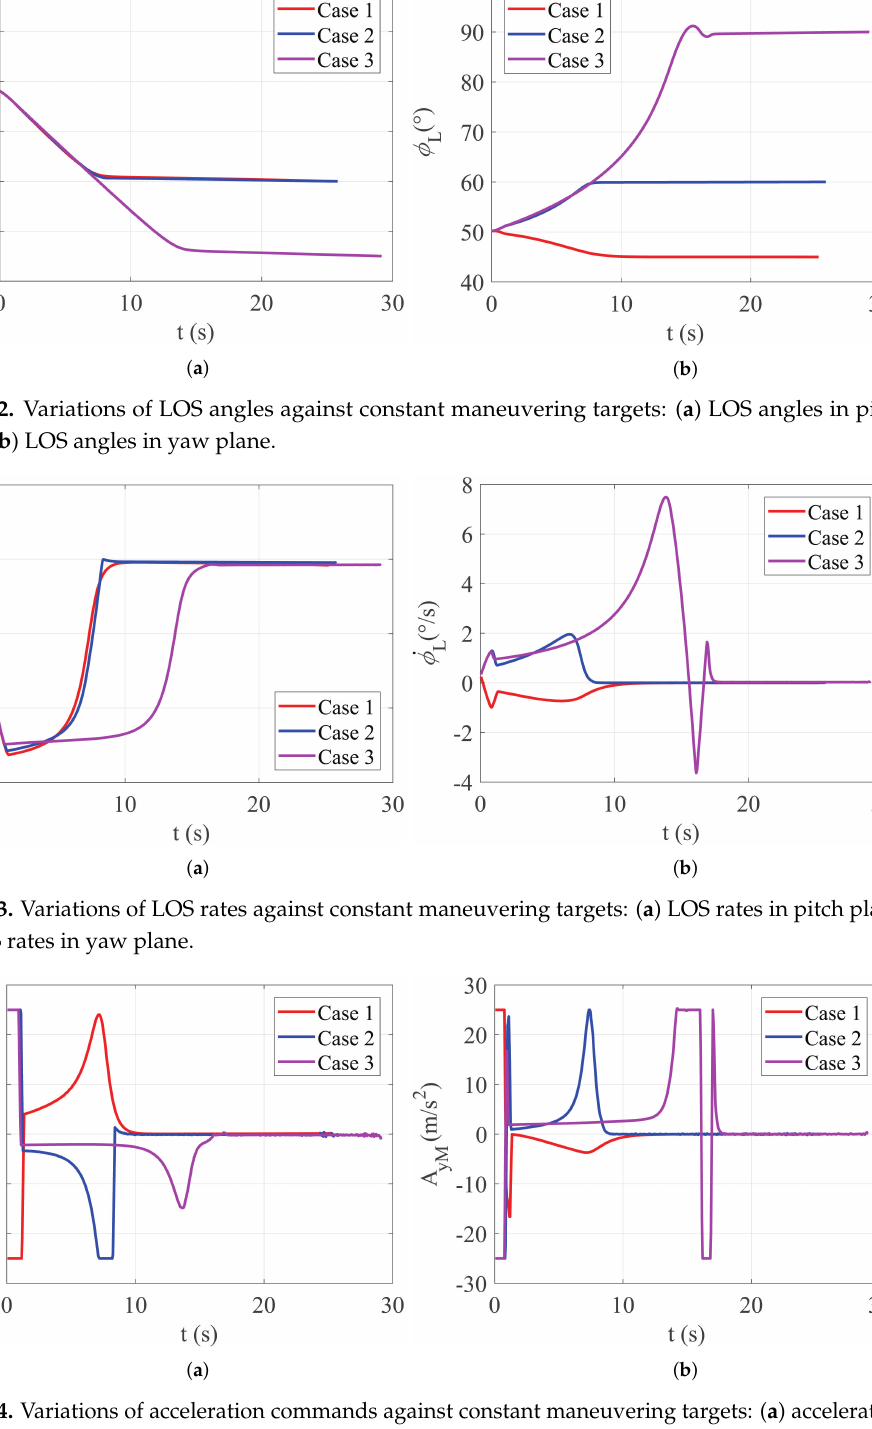
Figure 4. Variations of acceleration commands against constant maneuvering targets: ( a ) acceleration commands in pitch plane; ( b ) acceleration commands in yaw